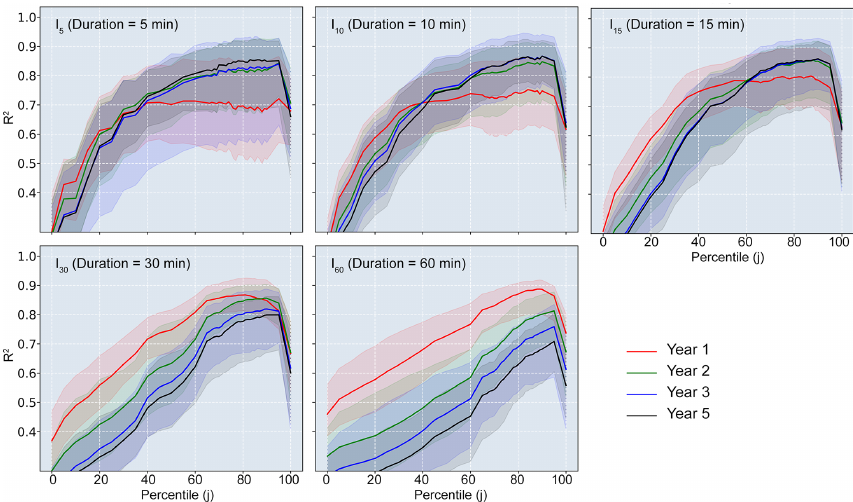
Figure 3. The determination coefficient ( R 2 ) and 95% confidence interval associated with the linear regression between I j discharge in post-fire years 1, 2, 3, and 5. Data used to fit the linear relation are from events with peak discharge greater than 2m 3 s − 1 .